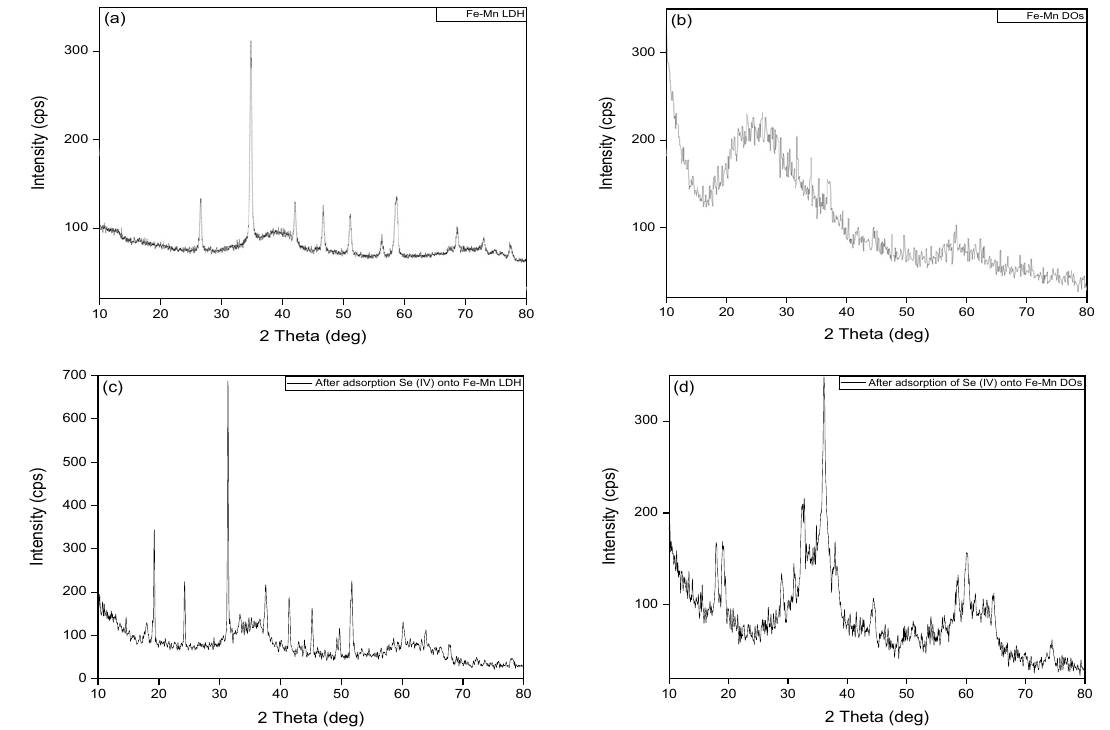
Fig. 1. XRD patterns of Fe-Mn LDHs before a) and after ion exchange reaction c) of selenite and Fe-Mn DOs before b) and after d) adsorption by